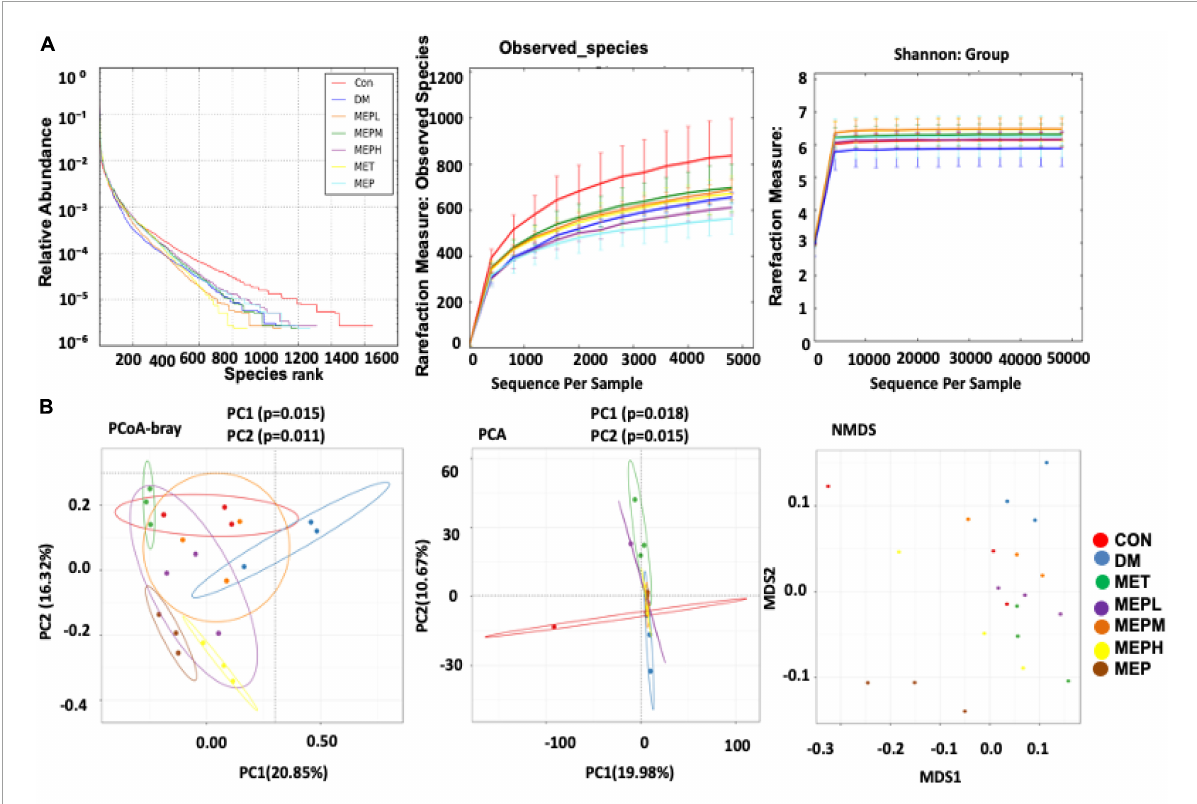
FIGURE4 Effect of MEP on bacterial diversity indices (alpha and beta) in T2DM mice. (A) The rank abundance curve, observed species, and Shannon show alpha diversity. The rank abundance curve represents bacterial abundance and richness, respectively, while the rarefaction measure of the observed species and Shannon index show species diversity, evenness, and abundance. (B) The beta diversity indices were analyzed by the PCoA, PCA, and NMDS plot. Every point represents each sample individually. Points with different colors indicate different treatment groups. The distance between the different points represents the differences and similarities within the bacterial community